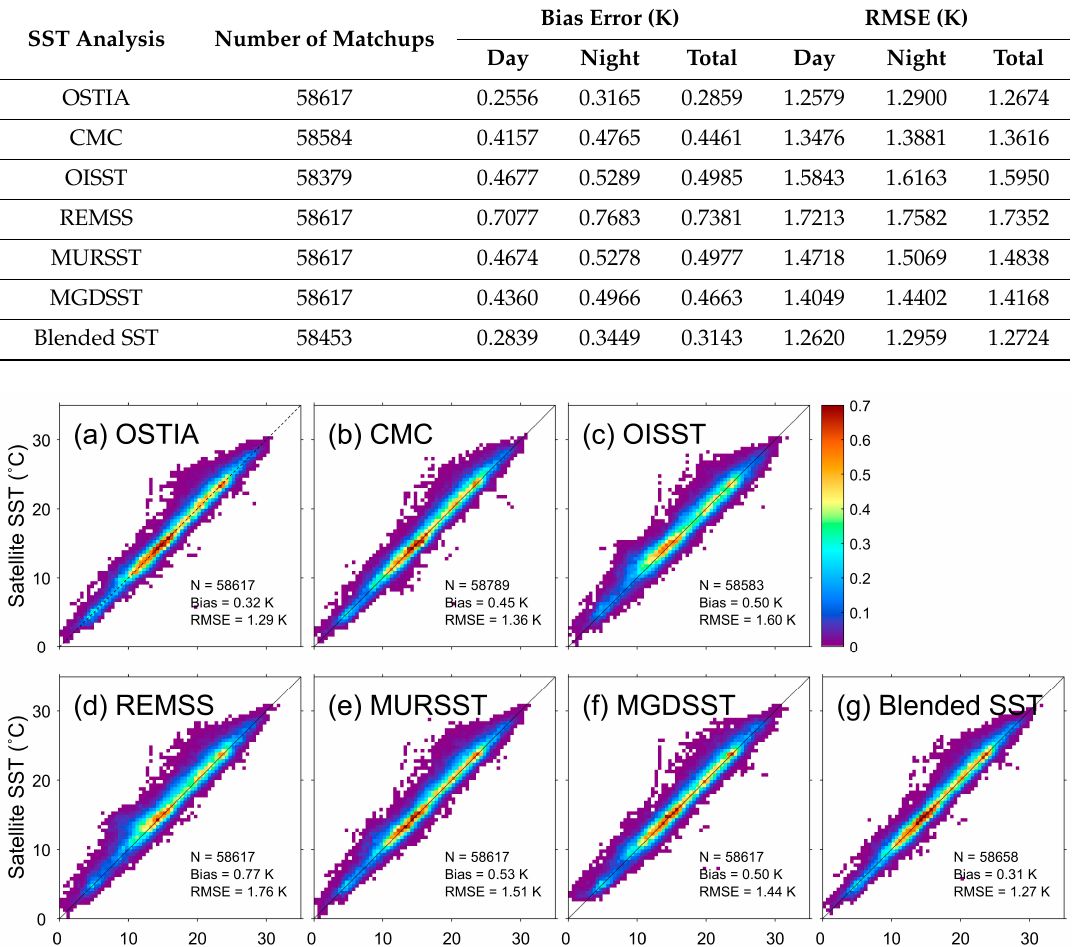
Table 3. Bias errors and root-mean-square errors (RMSEs) in SST analyses for in-situ measurements in the daytime, nighttime, and all day.